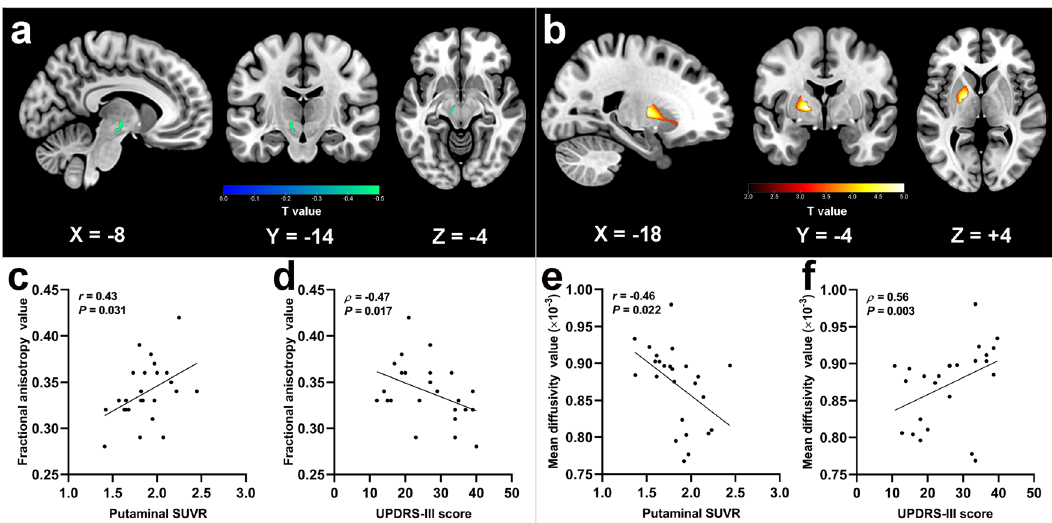
Fig. 2 The signi fi cantly different brain regions of FA and MD maps between groups, and scatter plots of correlations in PD group. Brain regions in MA side with signi fi cantly decreased FA ( a ) and increased MD ( b ) in PD group as compared with HC group. c Correlation between FA values of substania nigra ( X -axis) and putaminal SUVR ( Y -axis). d Correlation between FA values of substania nigra ( X -axis) and UPDRS-III scores ( Y -axis). e Correlation between MD values of putamen ( X -axis) and putaminal SUVR ( Y -axis). f Correlation between MD values of putamen ( X -axis) and UPDRS-III scores ( Y -axis). The